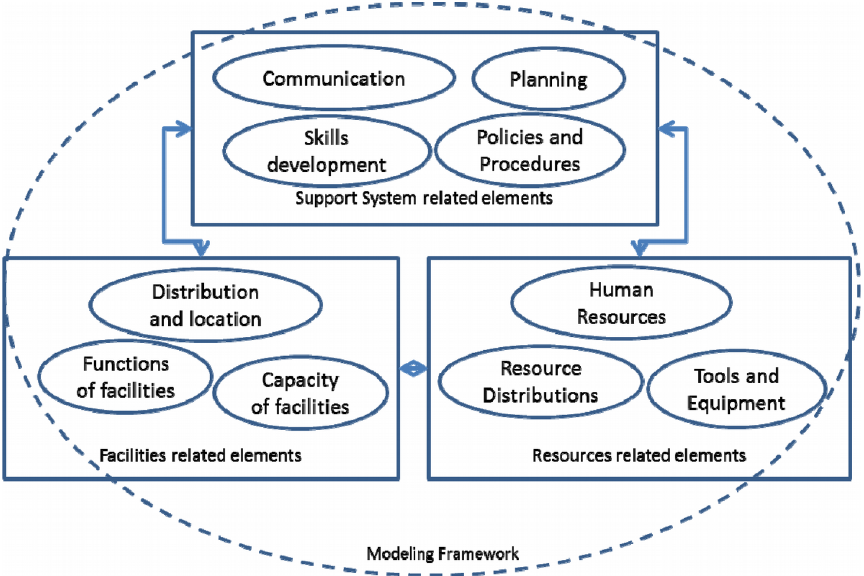
Figure 2. Sub-categories and elements in each phase of disaster response